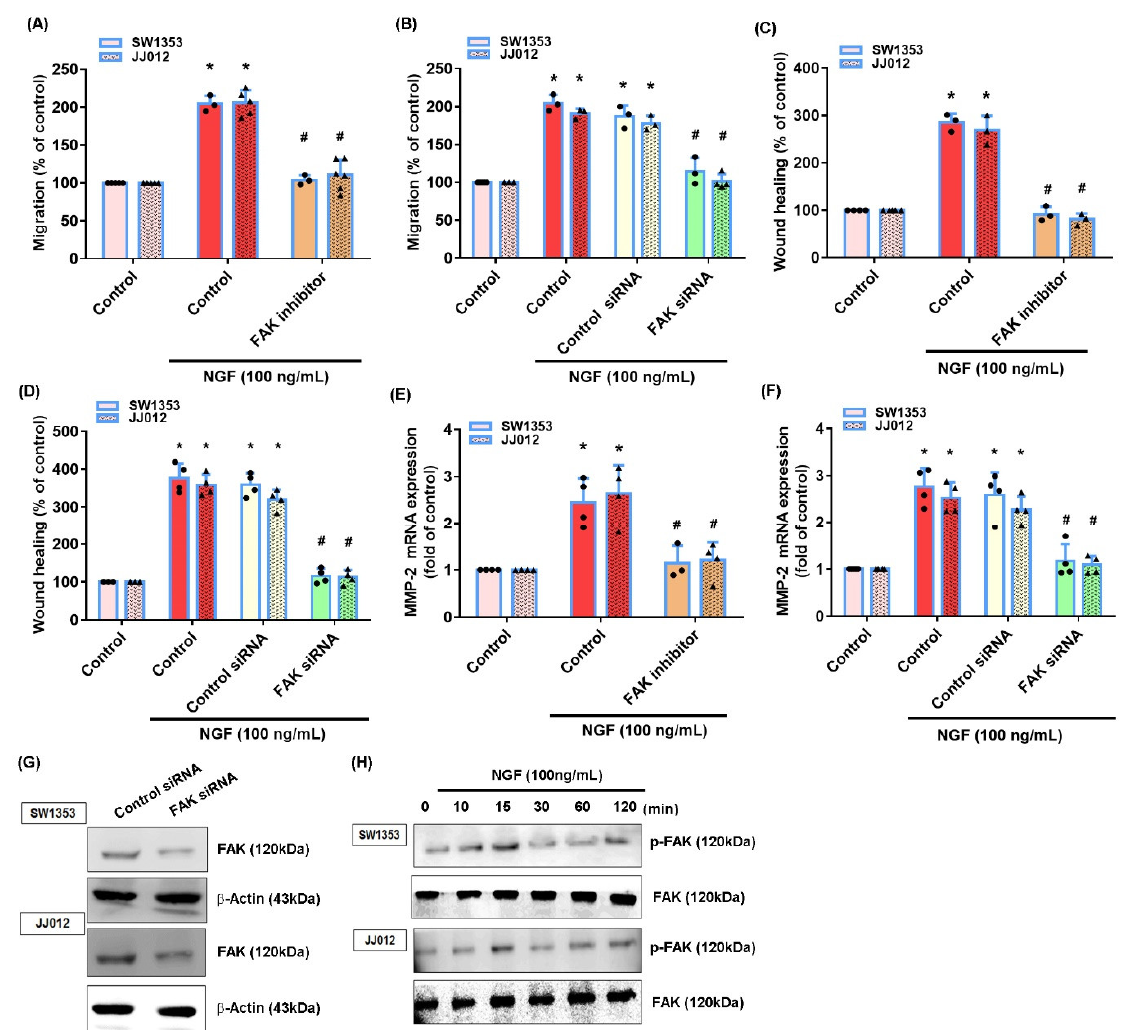
Figure 3. The FAK pathway mediates NGF-induced MMP-2 expression and cell migration. ( A – F ) Cells were pretreated with a FAK inhibitor or transfected with a FAK siRNA then stimulated with NGF. The cell migration and levels of MMP-2 expression were examined by Transwell, wound healing and qPCR. ( G ) Cells were transfected with a FAK siRNA and FAK expression was examined by Western blot. ( H ) Cells were incubated with NGF for the indicated time intervals; FAK phosphorylation was examined by Western blot. * p < 0.05 compared with the control group; # p < 0.05 compared with the NGF-treated group.